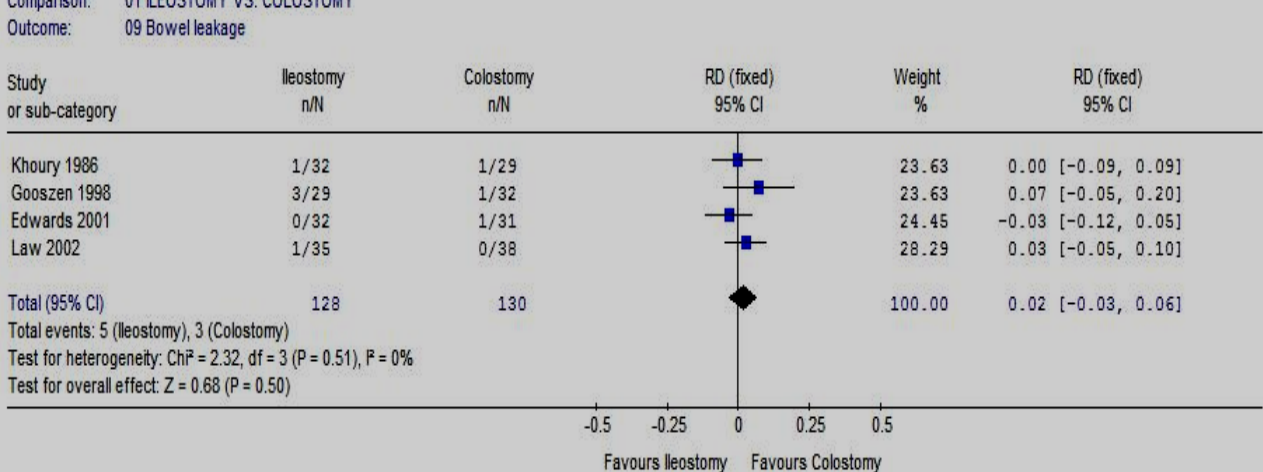
FIGURE 5 – Graph for the outcome of bowel